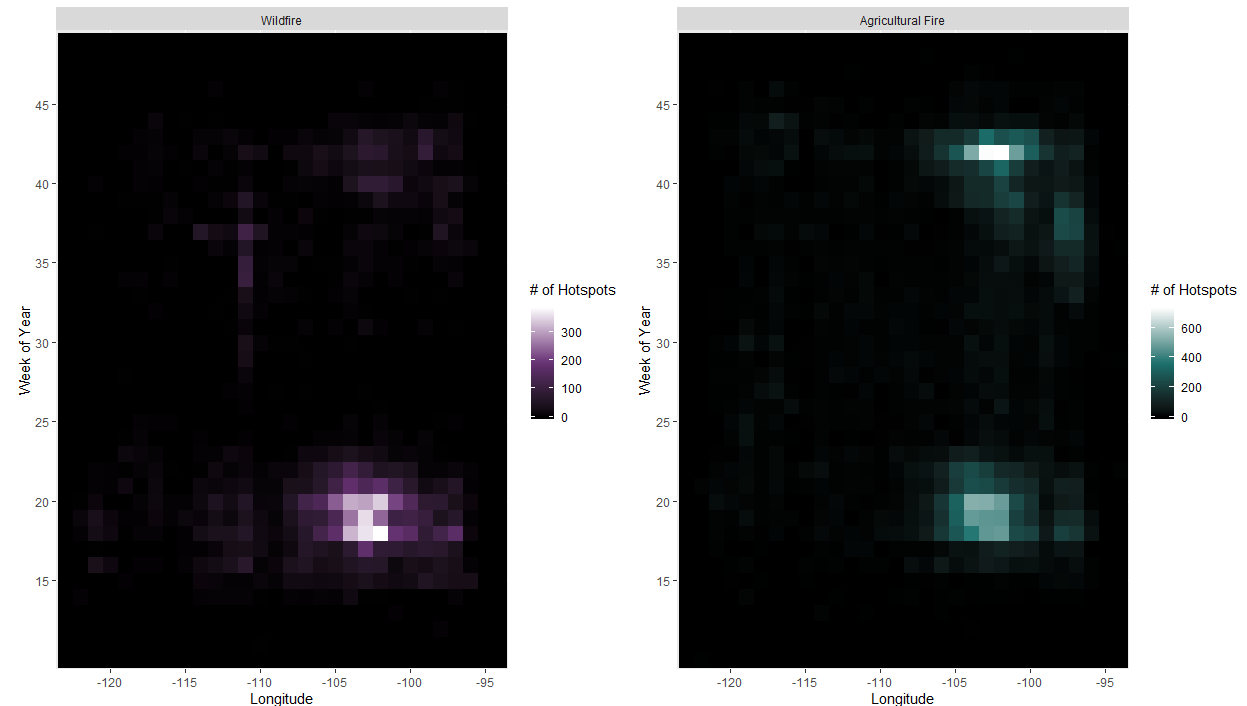
Figure 9. Hovmöller diagram showing seasonal patterns of wildfire vs. agricultural fire. In this diagram, the number of hotspot detections is summed across all latitudes within a longitude bin ( x axis) and is shown over time ( y axis). Values are the cumulative sum of detections from